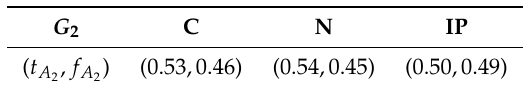
Table 3. Degree of vertices in vague graph G 2 .